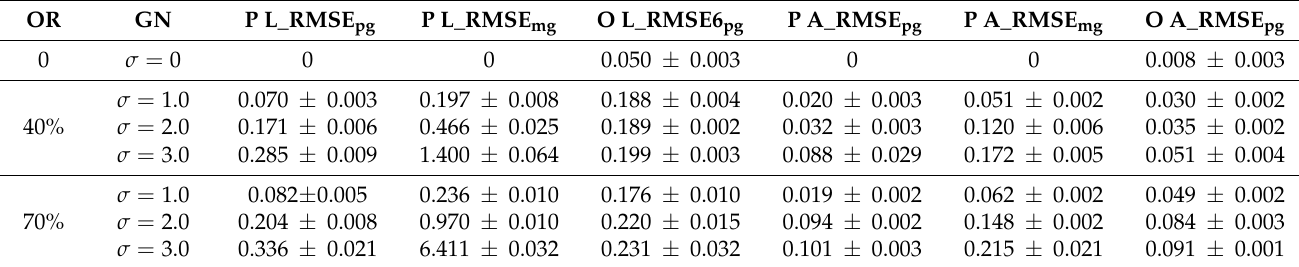
Table 1. Experiment I (linear and angular velocity accuracy) results. L_RMSE pg (m/s) compares predicted values to ground truth for linear velocity using the full system. L_RMSE mg (m/s) compares raw observations without Kalman filtering to ground truth for linear velocity. A_RMSE pg (rad/s) compares predicted values to ground truth for angular velocity. A_RMSE mg (rad/s) compares raw observations to ground truth for angular velocity. Values are means plus or minus standard deviations over 10 runs. The simulation uses a constant host vehicle angular velocity of ˙ θ = − 0.01 rad/s and a linear velocity of ˙ s = 15 m/s. OR = Outlier Ratio, GN = Gaussian Noise, P = Proposed Model, O = ORB-SLAM OR P L_RMSE pg